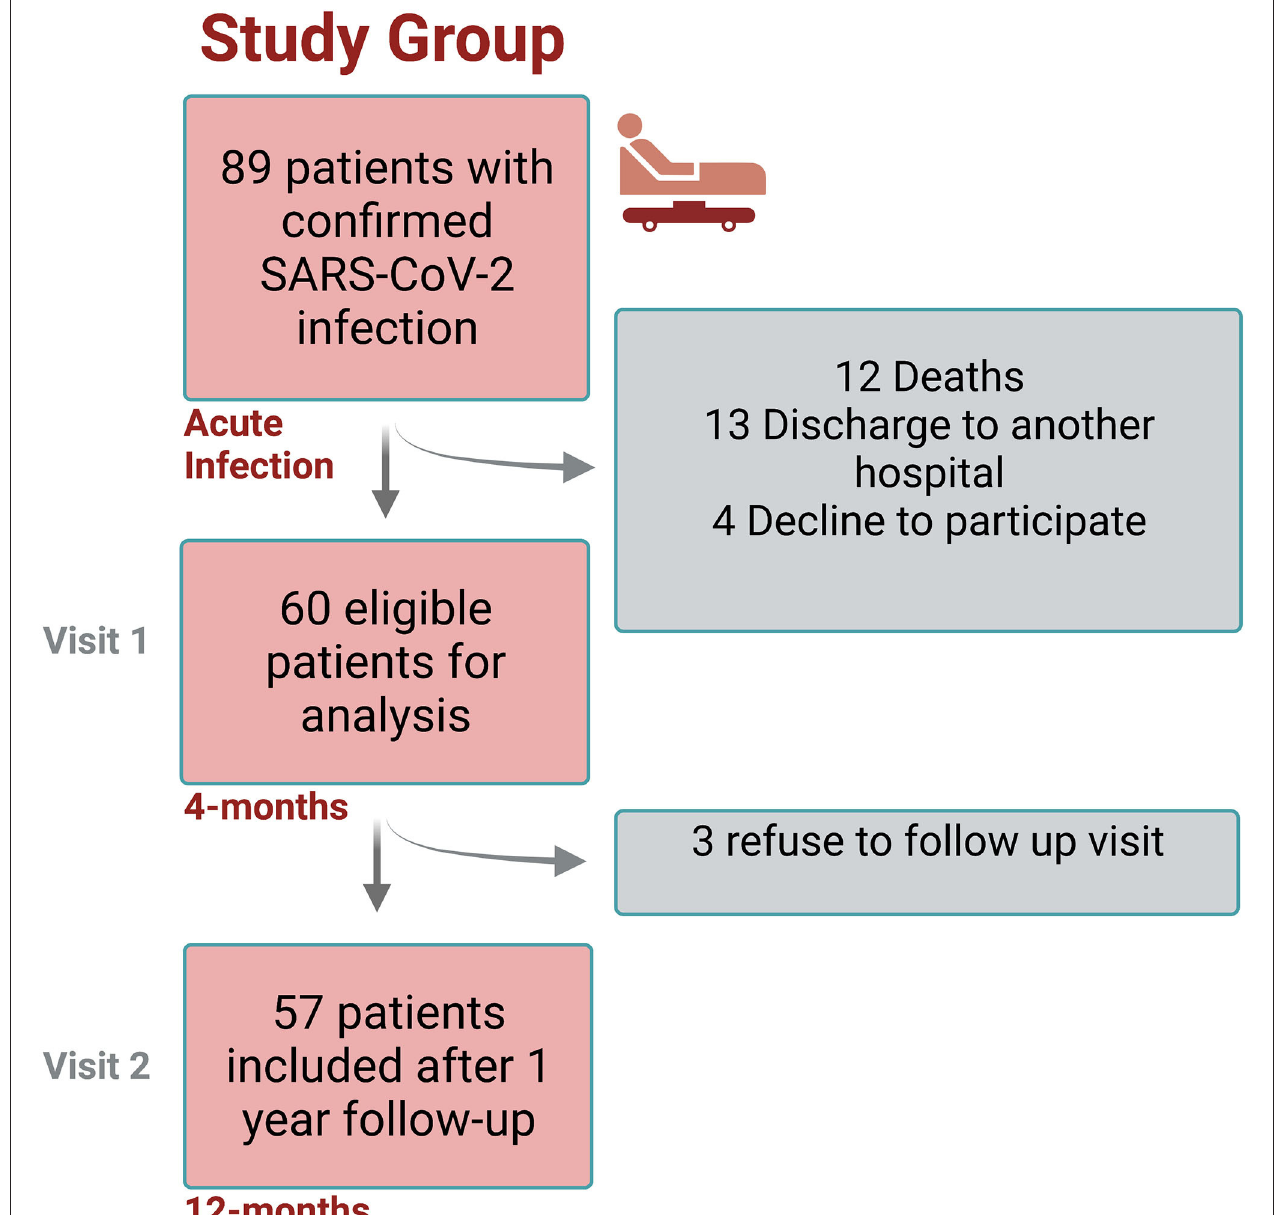
FIGURE 1 | Study design